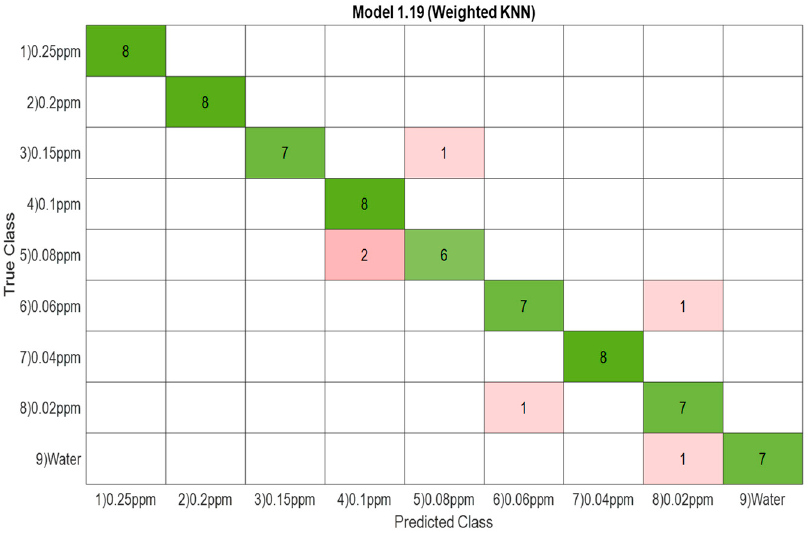
Figure 10. Confusion matrix for the kernel-weighted kNN model to classify Curathane pesticide at different concentrations against distilled water samples.